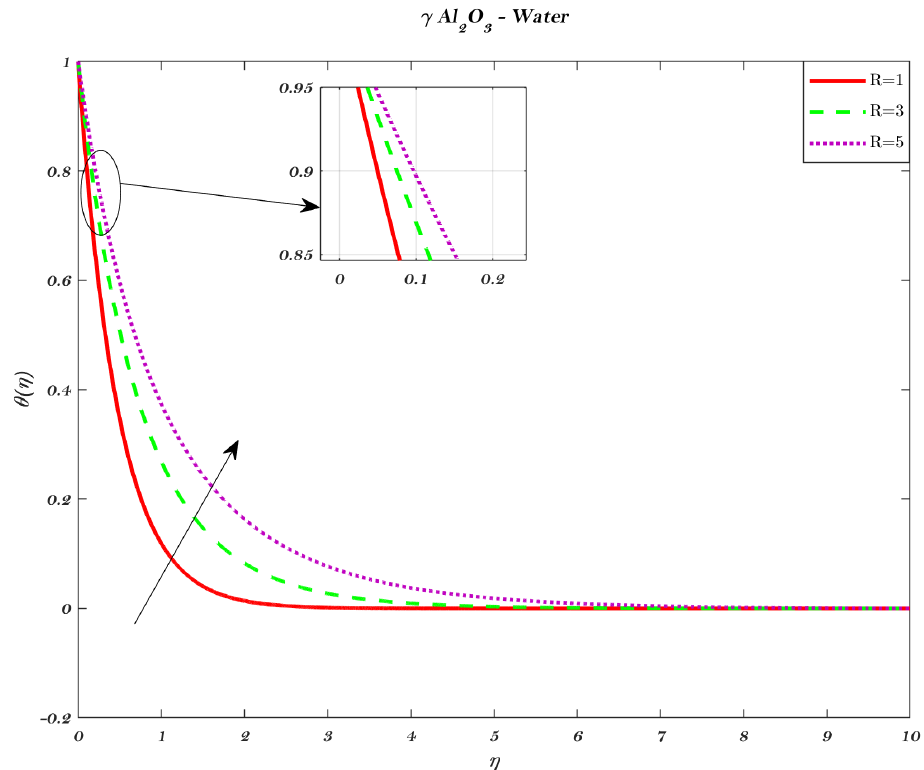
Figure 19. The radiative heat flux R against η with fix parameters ϕ = 2%, ˘ a = 0.02 and P r = 6.96.